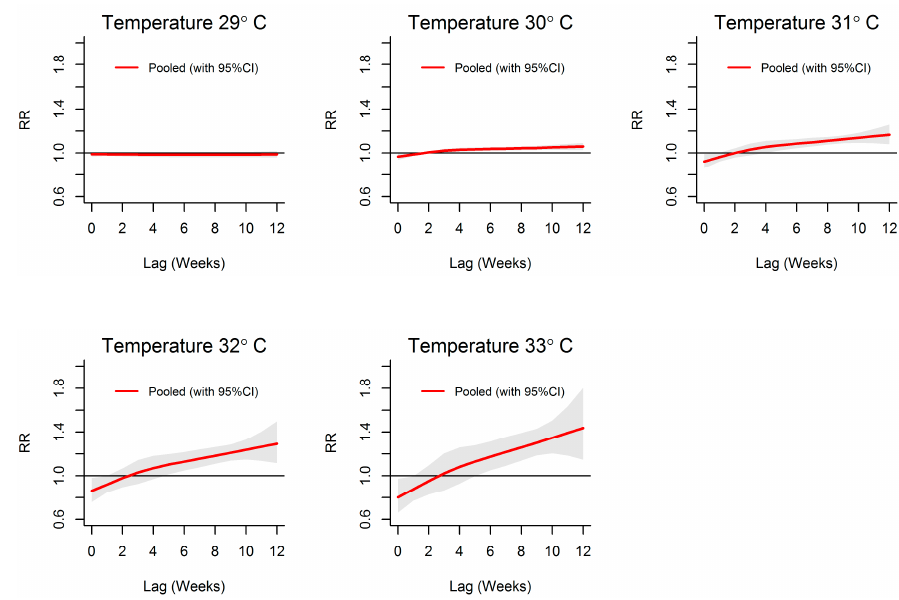
Figure 7. Relative risk (RR) of dengue by lag at specific weekly mean temperature levels predicted from the pooled exposure–response function for the 10 MOH divisions in Kalutara district, Sri Lanka, 2009–2013. The figure illustrates the predicted curves from meta-regression at specific temperatures (26, 27, 28, 29, 30, 31, 32, and 33 °C). Shaded areas represent 95% confidence intervals. All estimates for temperature relates to a reference of 29.8 °C. Int. J. Environ. Res. Public Health 2016 , 13 , 1087